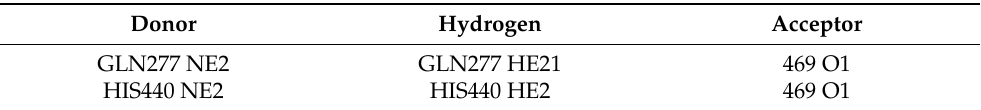
Table 12. Hydrogen bond donor and acceptor residues obtained from the molecular dynamic simulation (PPAR α ).